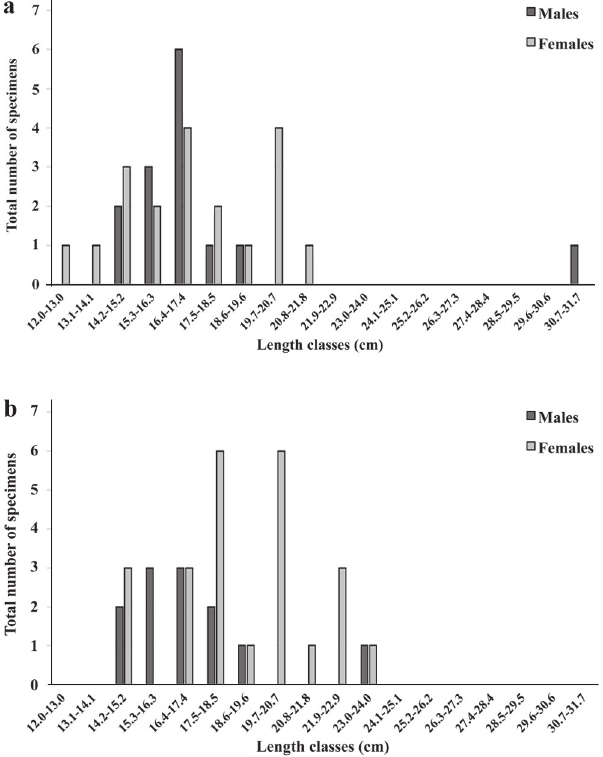
Fig. 5 . Distribution of Loricariichthys melanocheilus in the rio Ibicuí by length classes for separate sexes in point 3. a: Lagoon and b: River.